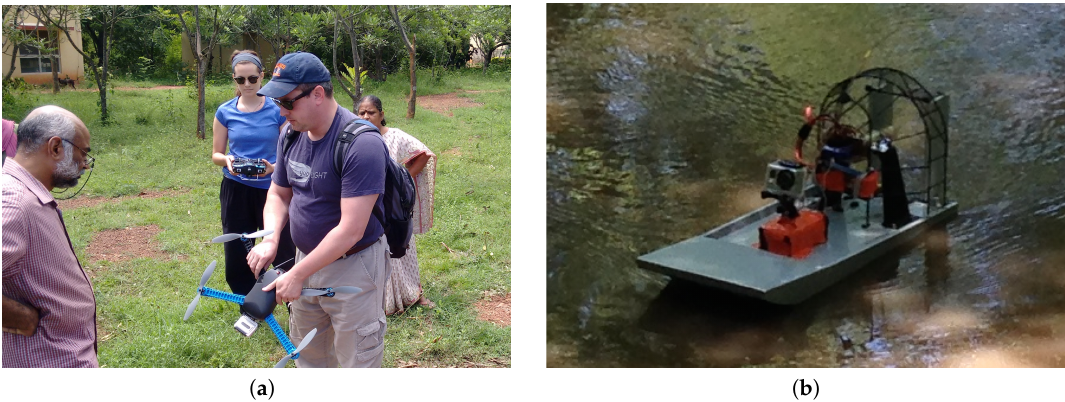
Figure 4. ( a ) Demonstrating the 3DR Iris quadcopter near Bangalore (note: the sensor shown here mounted to the UAV is different from the Sony ActionCam used for data acquisition); ( b ) The custom USV airboat used for bathymetric data collection in the Arkavathy